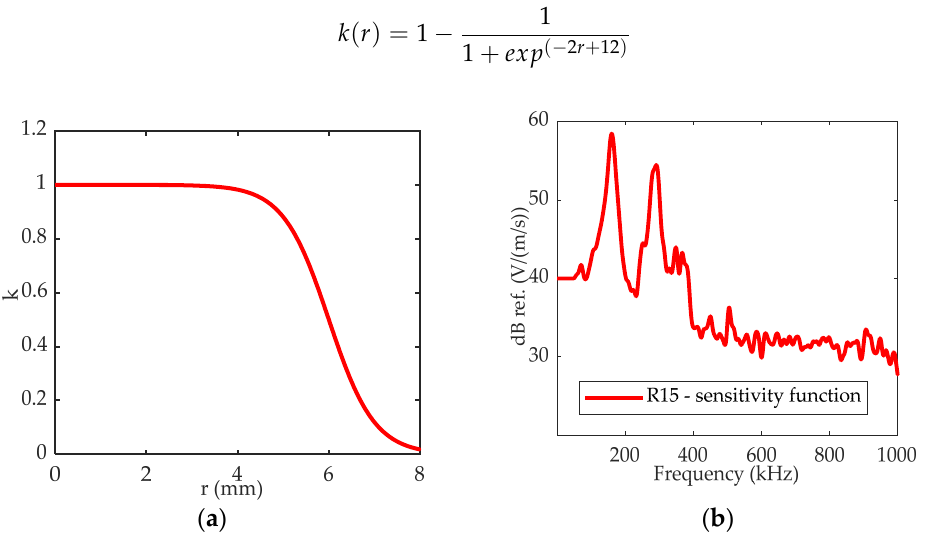
Figure 3. ( a ) Aperture function for the R15 sensors: evolution of the k factor versus the distance from the center of the sensor surface r . ( b ) Reception response of the R15 sensor obtained with the reciprocity method on a steel block.